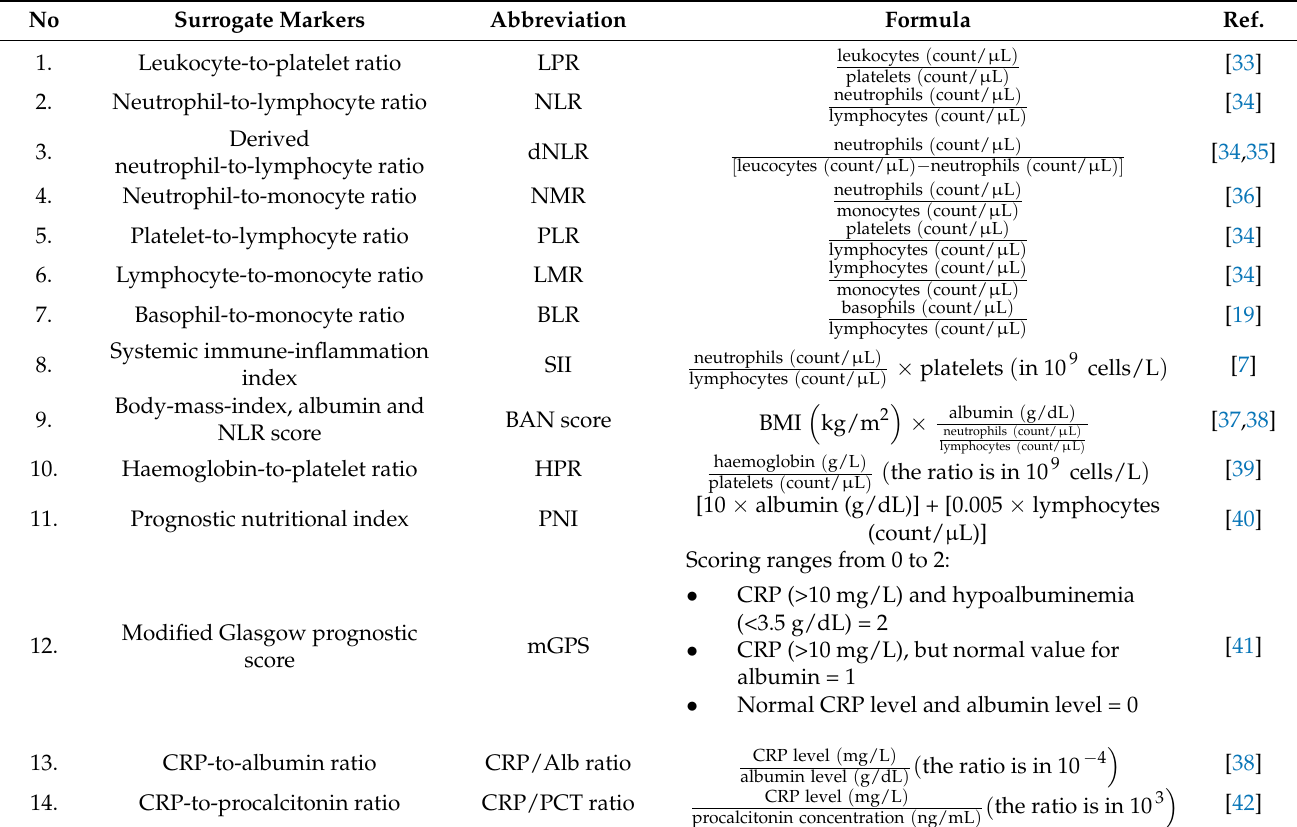
Table 1. The formulas of inflammatory surrogate